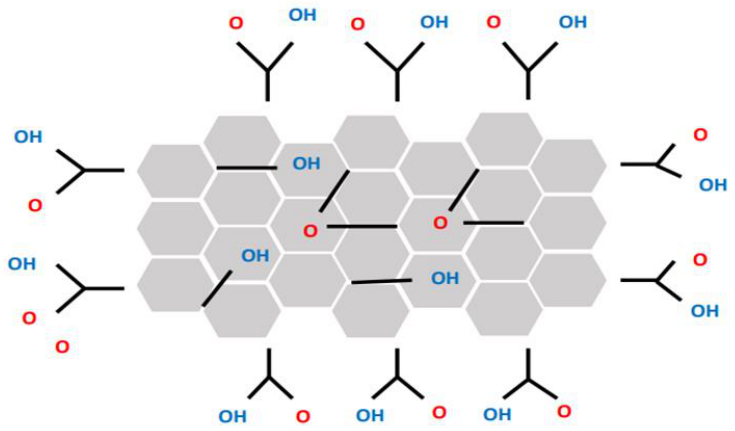
Figure 2. The structure of graphene oxide